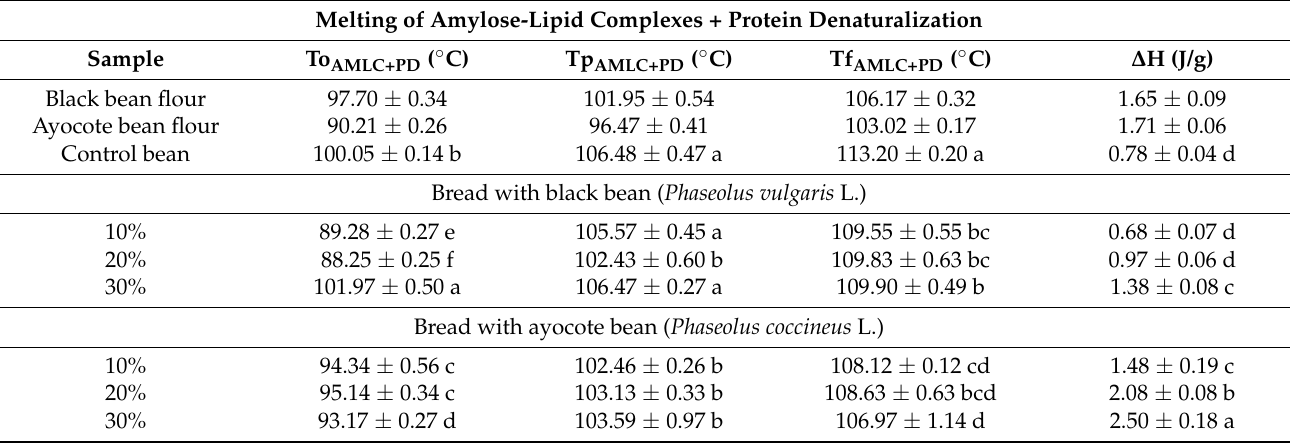
Table 4. Amylose lipid and protein denaturalization of black bean, ayocote bean, and breads by DSC analysis *. Melting of Amylose-Lipid Complexes + Protein Denaturalization